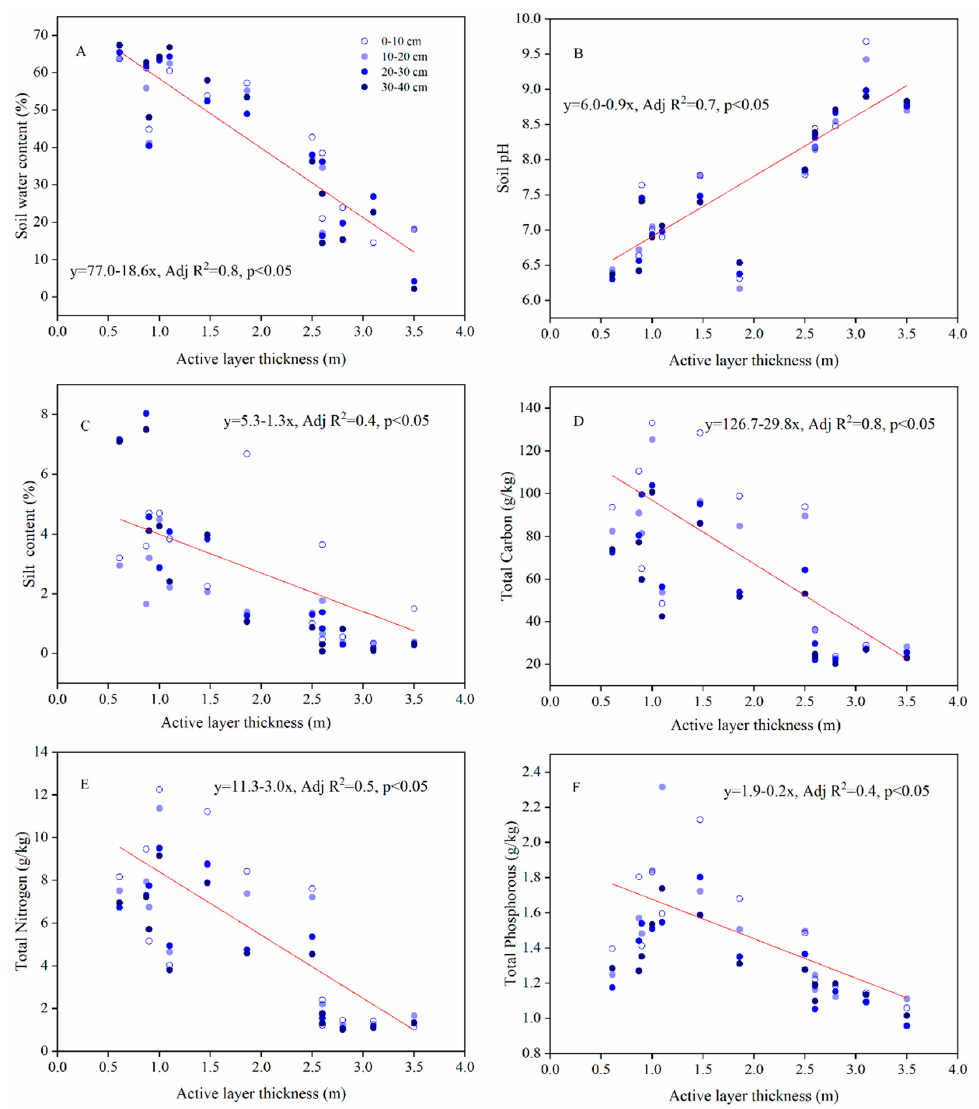
Figure 5. Relationships between soil properties and the active layer thickness. Notes: ( A ), soil water content; ( B ), soil pH; ( C ), silt content; ( D ), soil total carbon; ( E ), soil total nitrogen; and ( F ), soil total phosphorous.